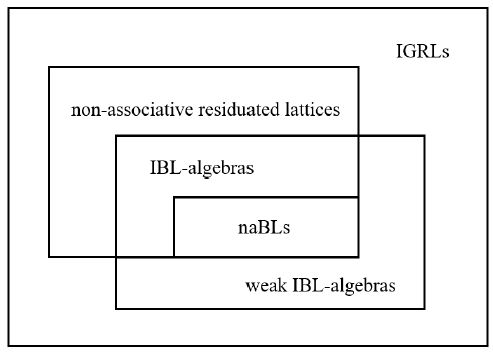
Figure 3. Relationship between several algebraic structures.